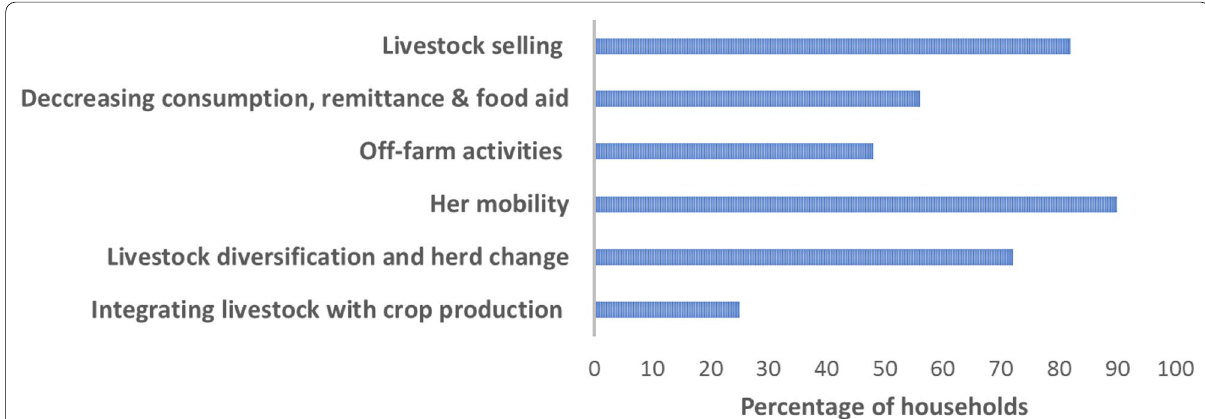
Fig. 2 Adaptation/coping strategies employed by pastoral households in Fentale